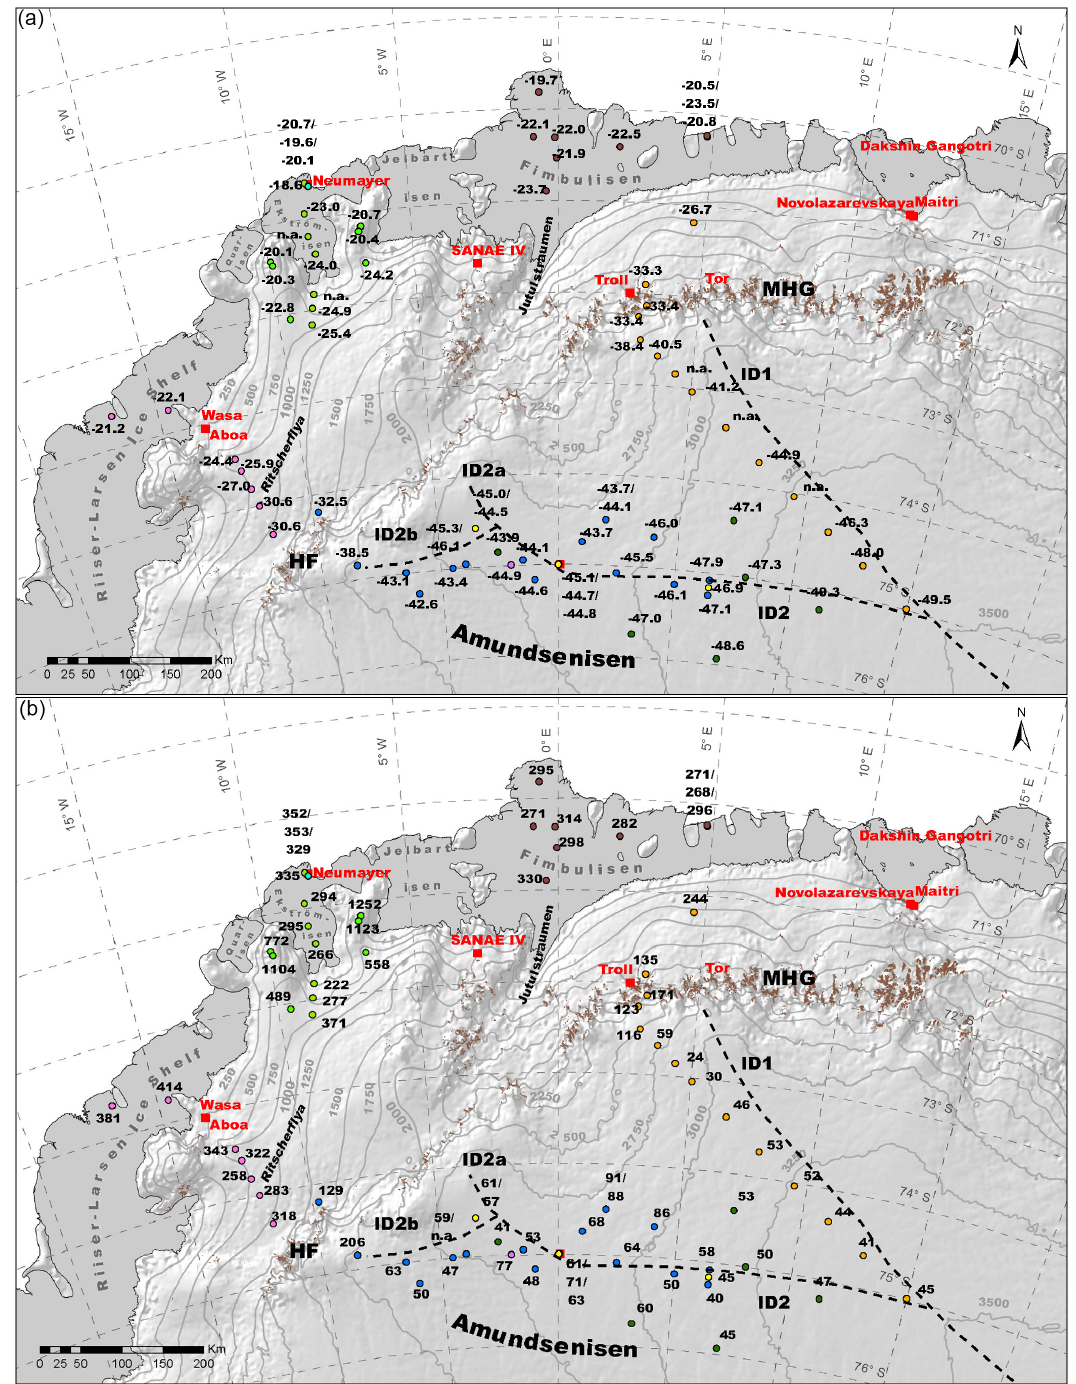
Figure 2. (a) Mean annual δ 18 O (‰) for the complete time series of each core. Labels in (a) and (b) are arranged in the same way as in Fig. 1 (NA: not available). (b) Mean annual SMB (kgm − 2 ) for all firn and ice cores (NA: not available).